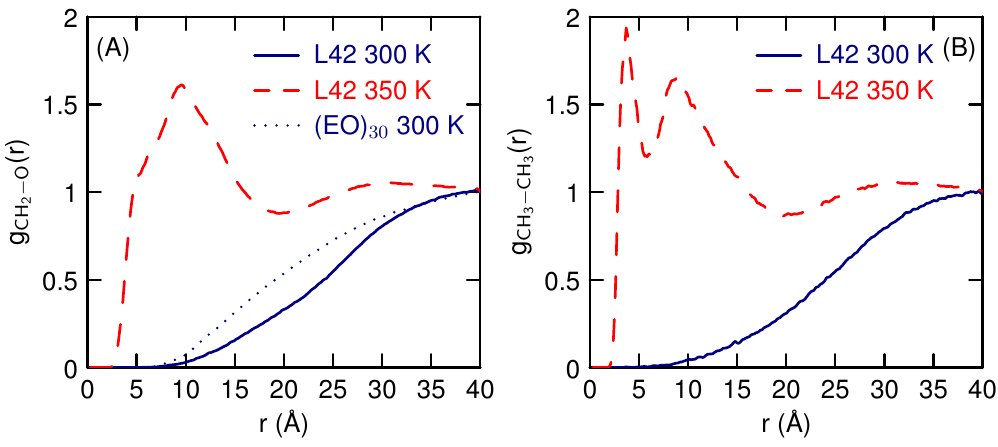
Figure 13. Radial distribution functions between atoms on different polymer strands for CH 2 –O ( A ) and CH 3 –CH 3 ( B ) atoms.